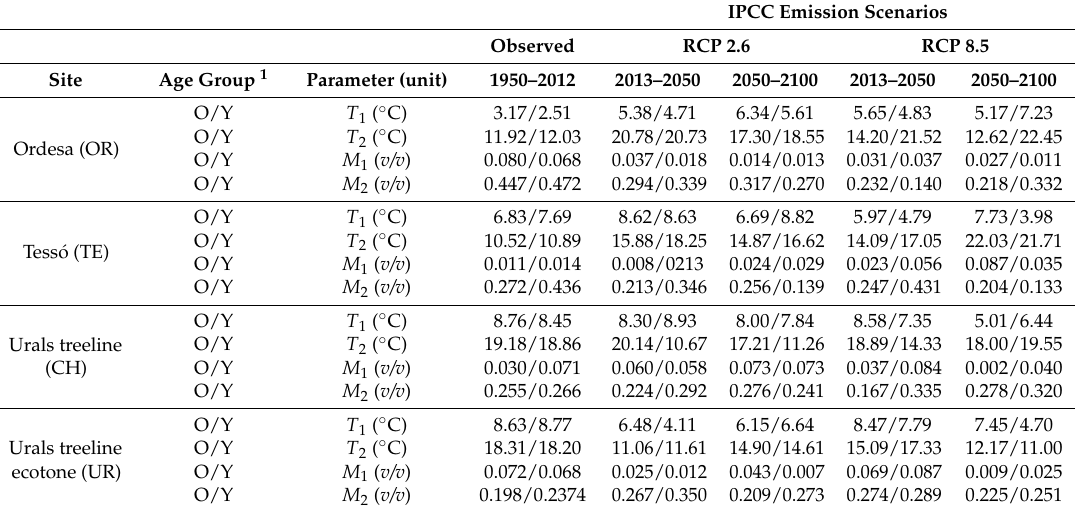
1 Abbreviations: O, old trees; Y, young